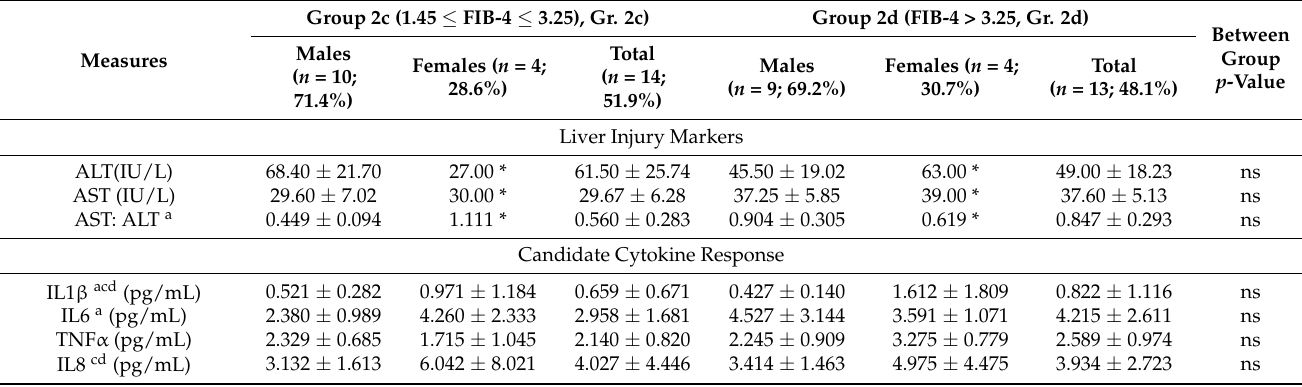
Table 4. Liver injury measures, nutritional status, candidate blood panel measures, cytokines, gut dysfunction markers, and cell death markers of the alcohol use disorder patients after 2 weeks of SOC comparing patients by baseline FIB-4, tabulation by moderate (Gr.2c) and severe elevation of FIB-4